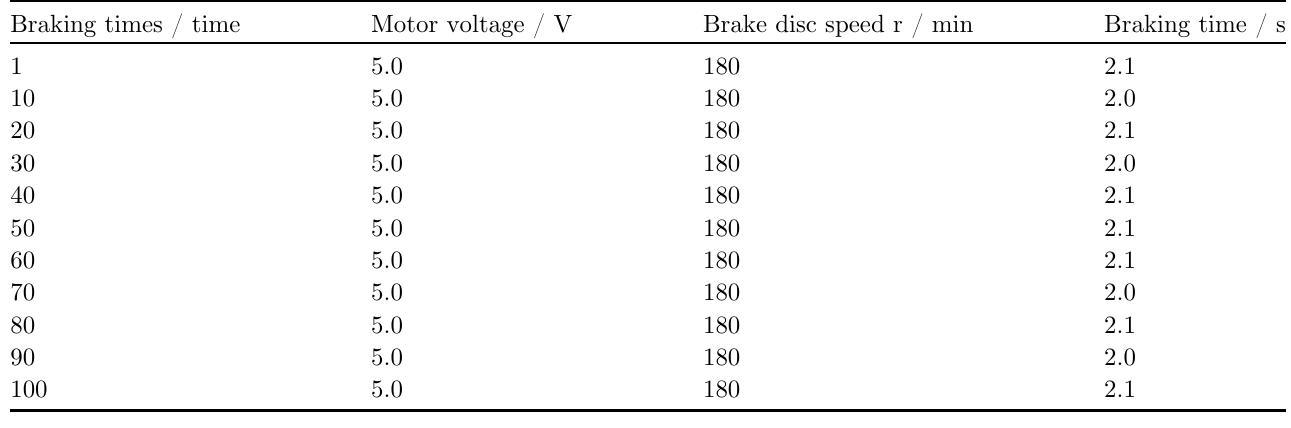
Table 7. Data sheet of reliability performance test.